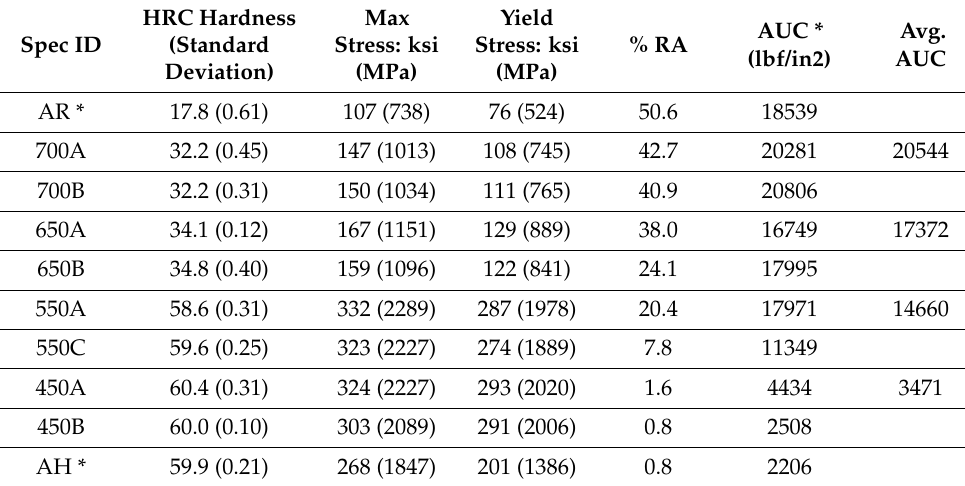
Table 2. Results of the tensile test and Rockwell hardness